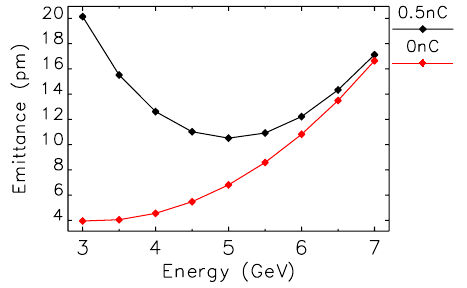
¼ (cid:6) vs energy for a round beam at x y